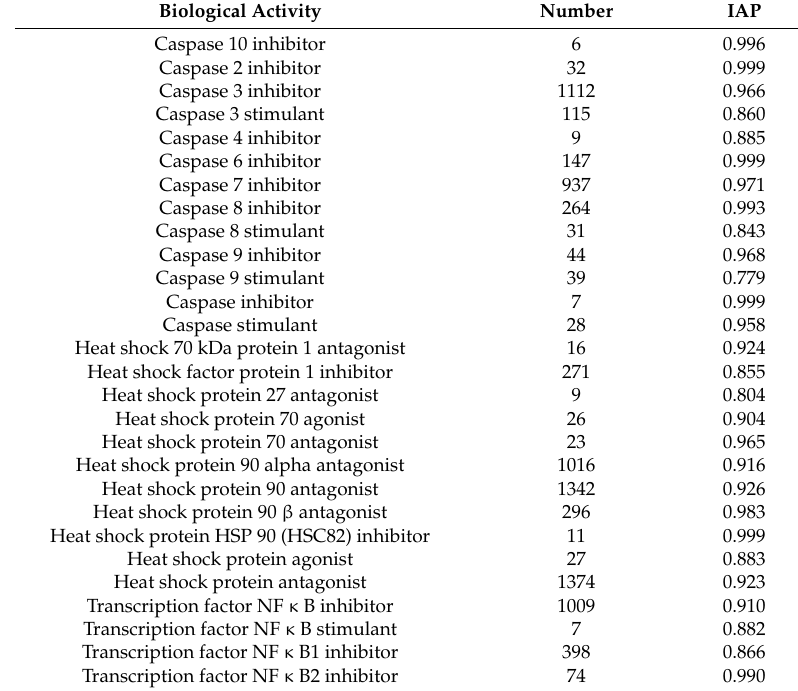
Table 2. List of biological activities predicted by PASS 2017 and associated with interaction of drug-like compounds with the selected